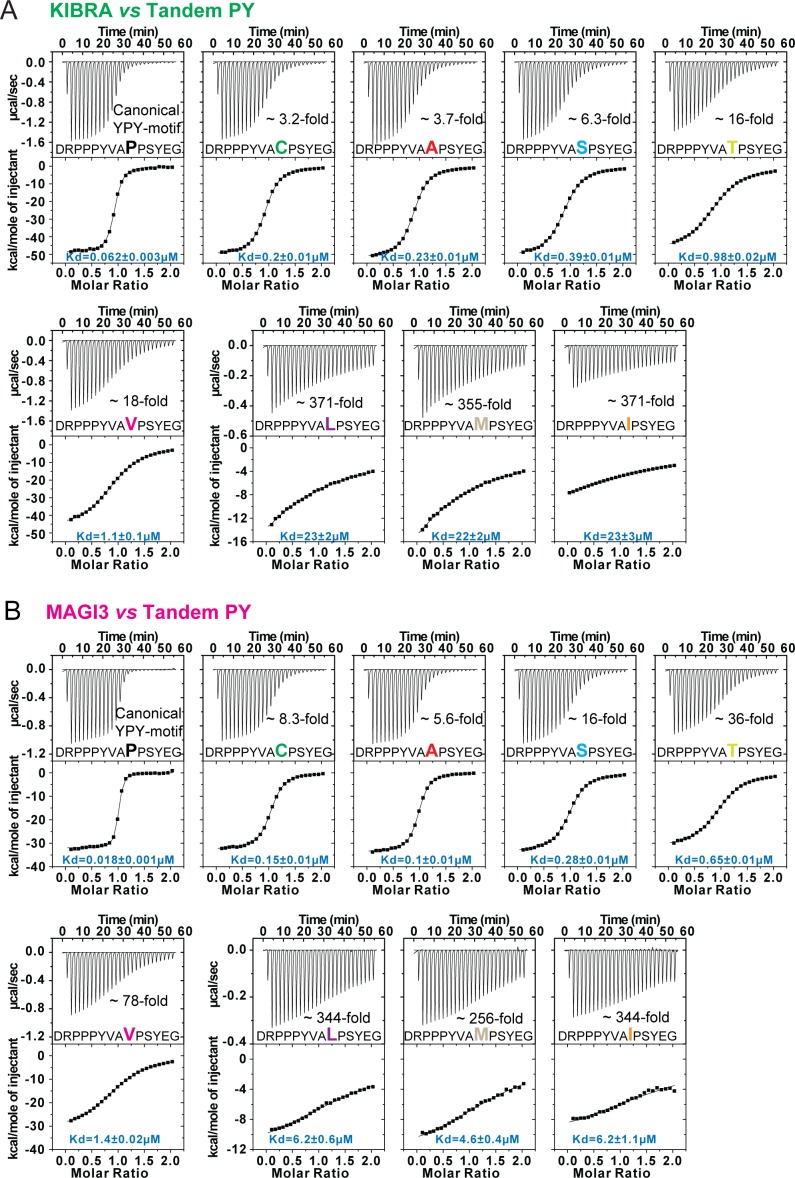
Bindings between WW tandems and closely spaced PY motifs with 2nd PY variation.(A and B) ITC-based measurements comparing the binding of WW tandems from KIBRA (A) and MAGI3 (B) to Dendrin-PY23 with variations on 2nd PY motif.